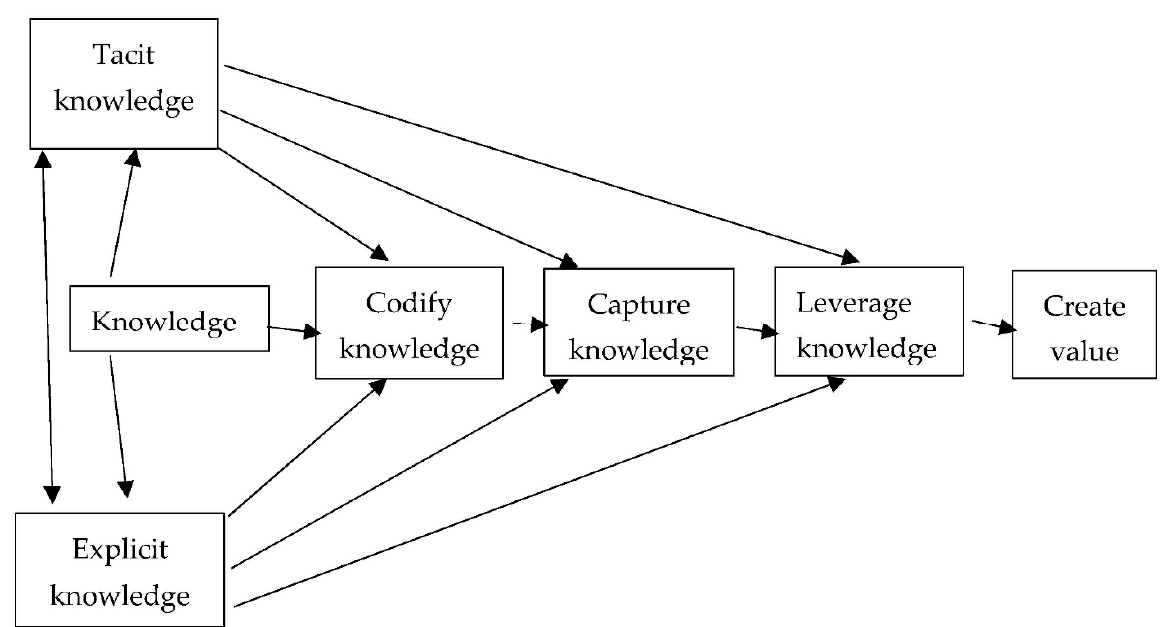
Figure 4. From knowledge to value creation .